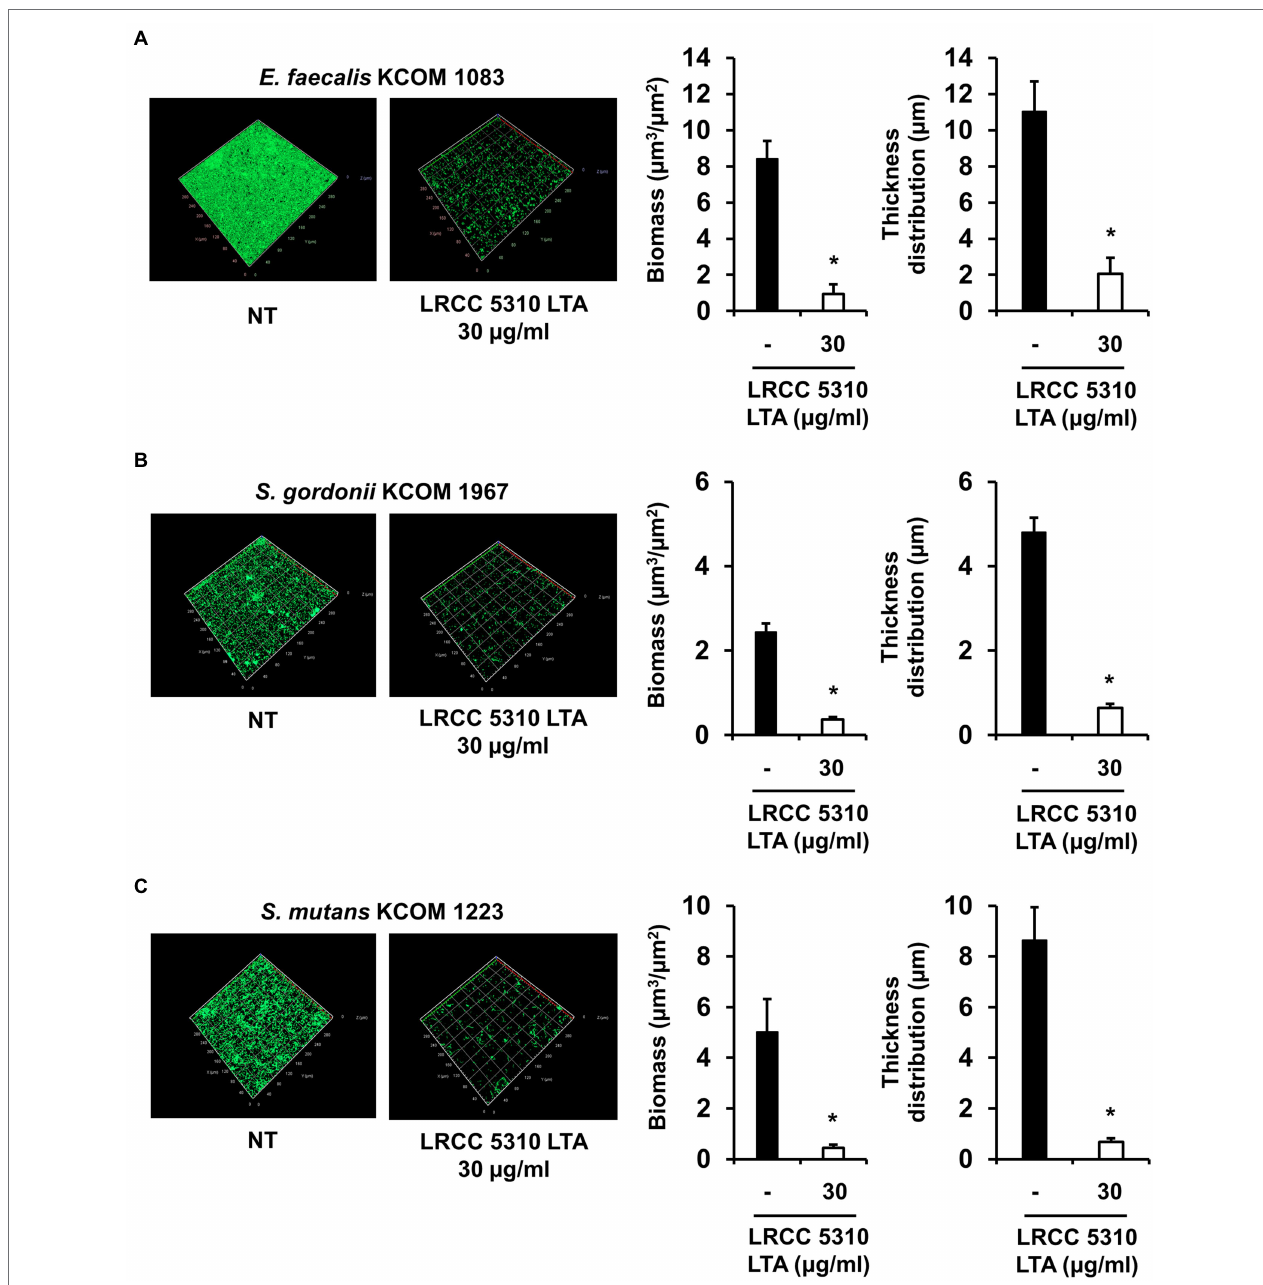
FIGURE 5 | LRCC 5310 Lp.LTA inhibits biomass and thickness distribution of biofilm formed by clinically isolated E. faecalis , S. gordonii , and S. mutans . Clinically isolated strains of (A) E. faecalis (KCOM 1083), (B) S. gordonii (KCOM 1967), and (C) S. mutans (KCOM 1223) at 1 × 10 7 CFU/ml were grown on glass-bottom confocal dishes at 37 ° C for 24 h in the presence or absence of 30 μ g/ml of LRCC 5310 Lp.LTA. After the incubation, biofilms were stained with the LIVE/DEAD BacLight Bacterial Viability Kit containing SYTO9 and propidium iodide and then visualized by confocal laser microscopy (green SYTO9; red, propidium iodide). The biomass and thickness distribution of biofilms were quantified using COMSTAT2 software. Asterisk (*) indicates statistical significance at p < 0.05 between the non- treatment and LRCC 5310 Lp.LTA treatment